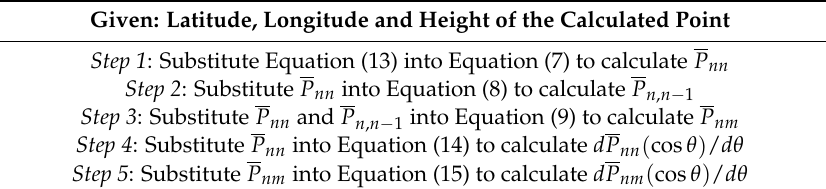
Table 1. Iterative algorithm of the fully normalized Legendre